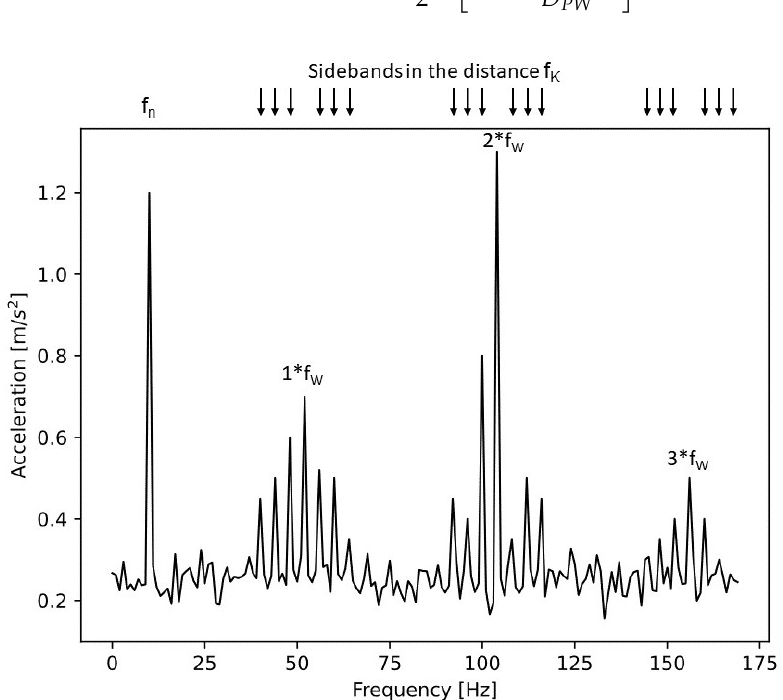
Figure 4. Envelope curve spectrum of a ball bearing with advanced rolling element